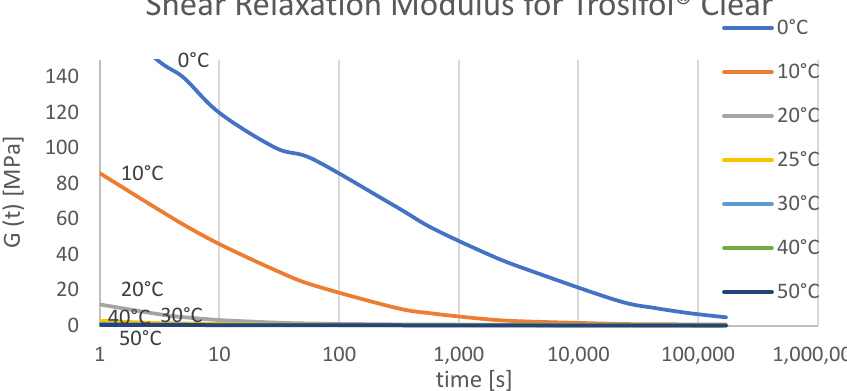
Figure 8. Shear Relaxation curves for PVB Clear from Trosifol ® data sheet at different temperatures.